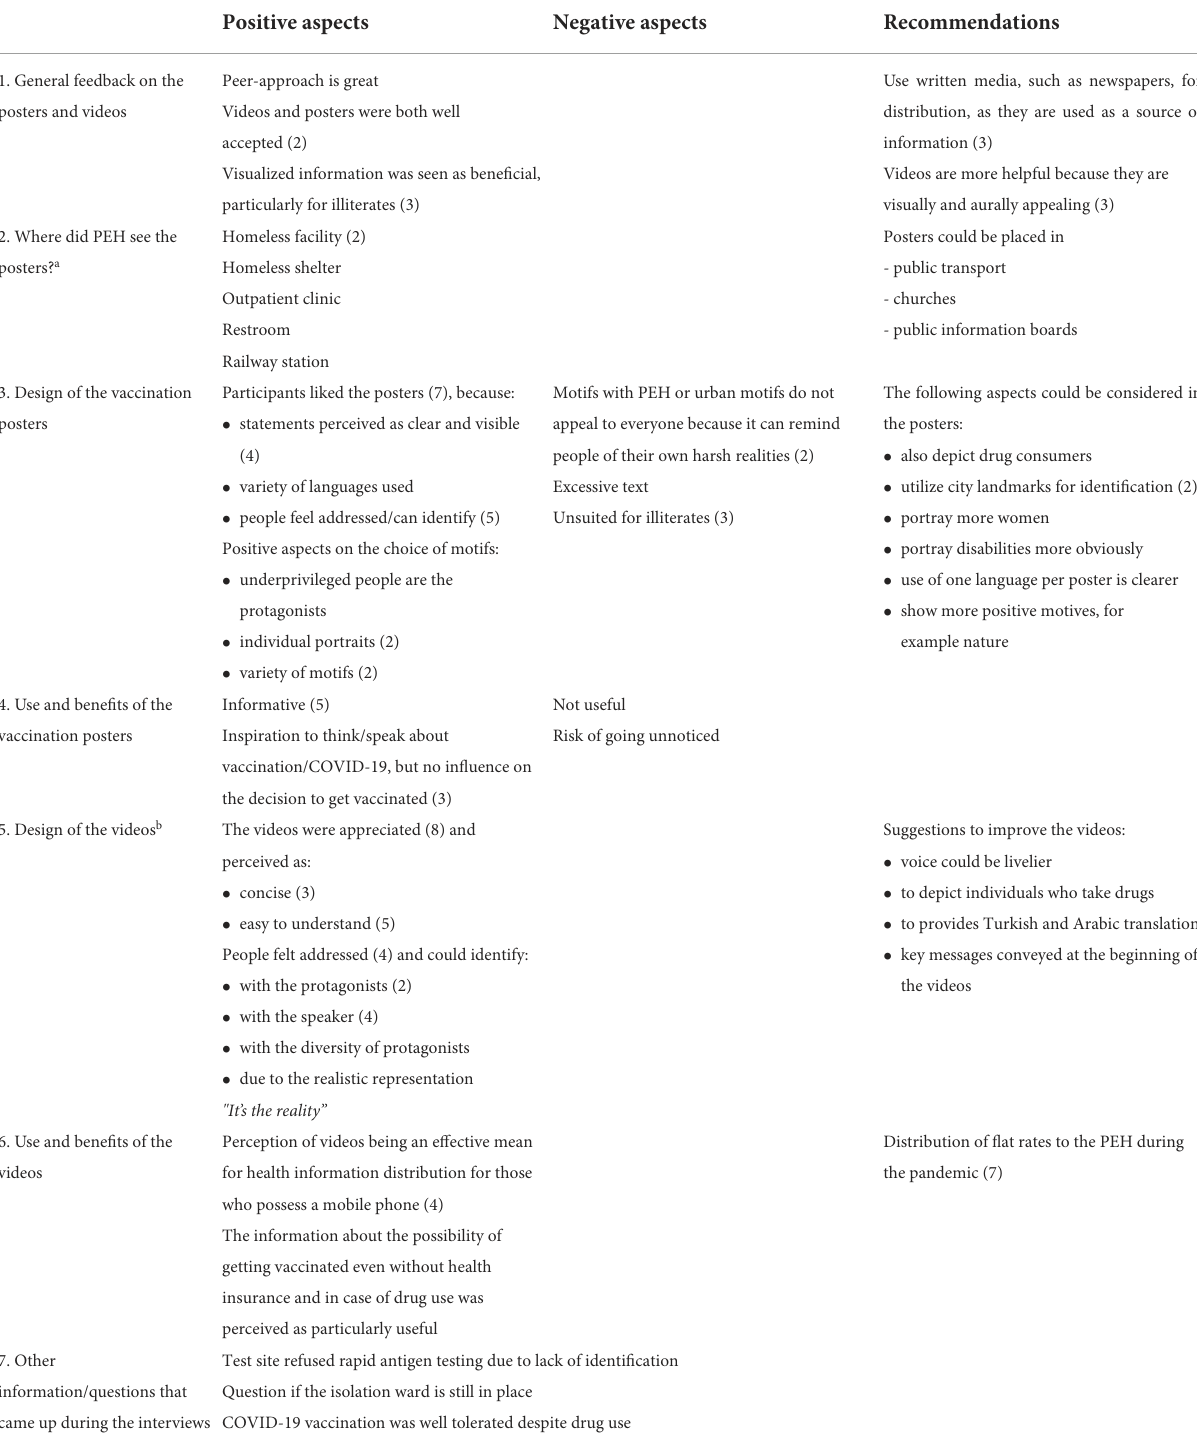
TABLE 2 Evaluation of the videos and posters according to semi-structured interviews with 8 people experiencing homelessness (PEH). Positive aspects Negative